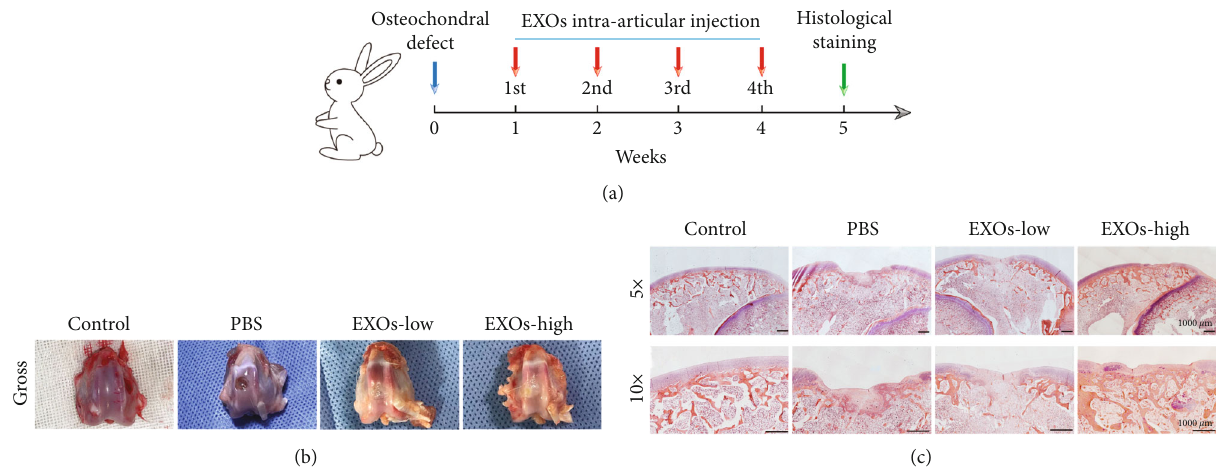
Figure 5: hBMSC-EXOs promote cartilage formation after injury in rabbits. (a) The experimental design. Defects were generated in the articular cartilage of rabbits, and then, hBMSC-EXOs were given to rabbits via intra-articular injection for 4 times. (b) The gross appearance of rabbit articular cartilages. (c) H&E staining. Scale bar = 1000 μ m . EXOs-low: 1 × 10 10 /ml ; EXOs-high: 5 × 10 10 /ml .